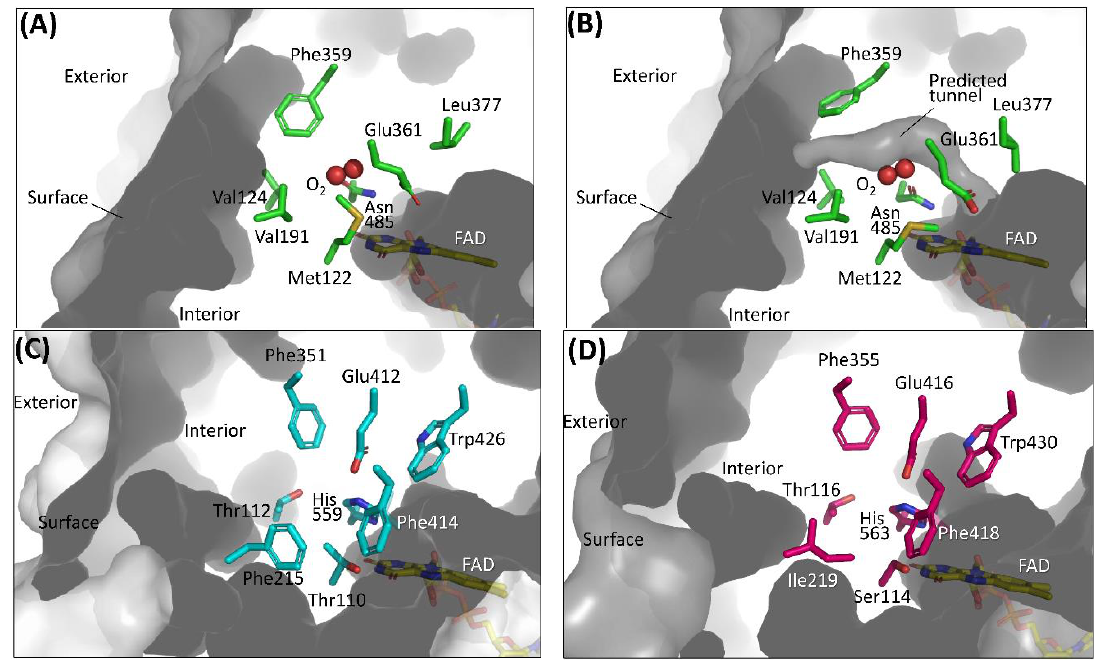
Figure 3. Amino acid residues composing the cavity where oxygen may be located in ( A ) ChOx (PDB code: 1MXT) conformation A, closed state; ( B ) ChOx (PDB code: 1MXT) conformation B, open state; ( C ) AnGOx (PDB code: 1CF3); ( D ) PaGOx (PDB code: 1GPE). Structure visualization was conducted using the PyMOL Molecular Graphics System, Version 2.2.3 Schrödinger, LLC. Tunnel visualization was performed for (A) and (B) by the PyMOL plugin CAVER 3.0.1. [51]. The starting point was